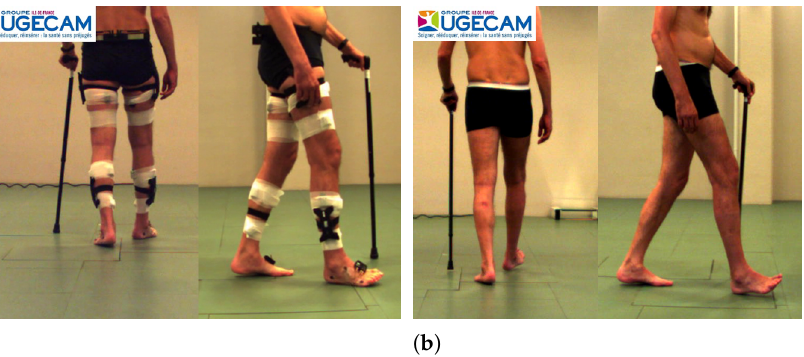
Figure 1. Example of the outcome of BTX-A treatment on gait ( a ) before treatment ( b ) after BTX-A treatment.